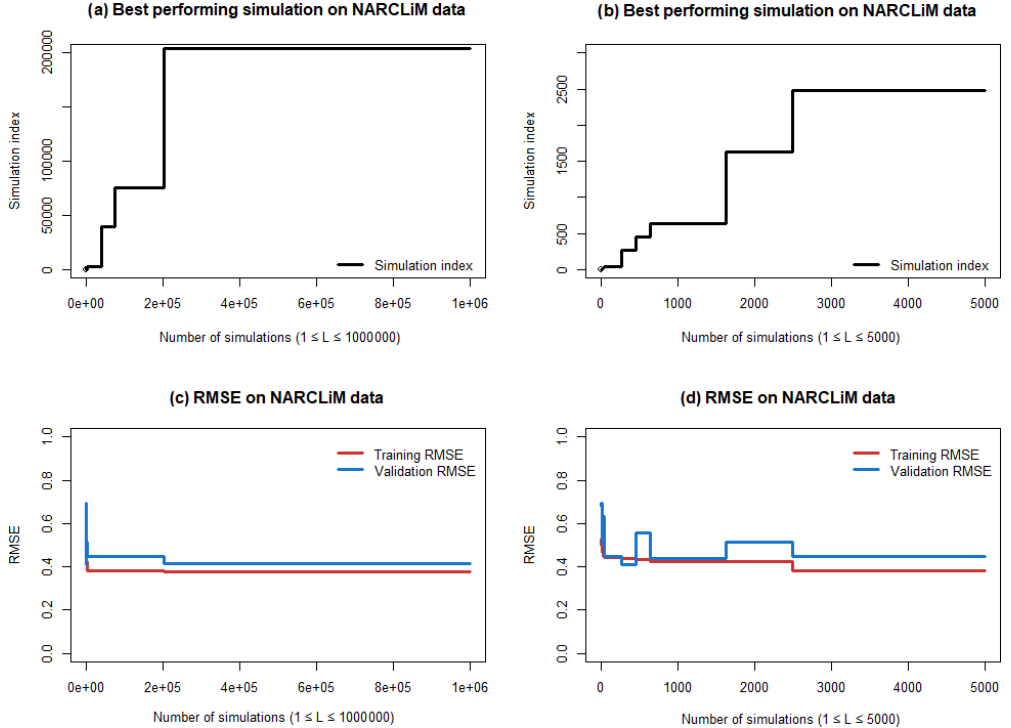
Figure 1. Sensitivity of the ensemble properties to the value of L . Left panels (a) and (c) contain results from all the simulations. Right panels (b) and (d) contain the results from the first 5000 simulations.